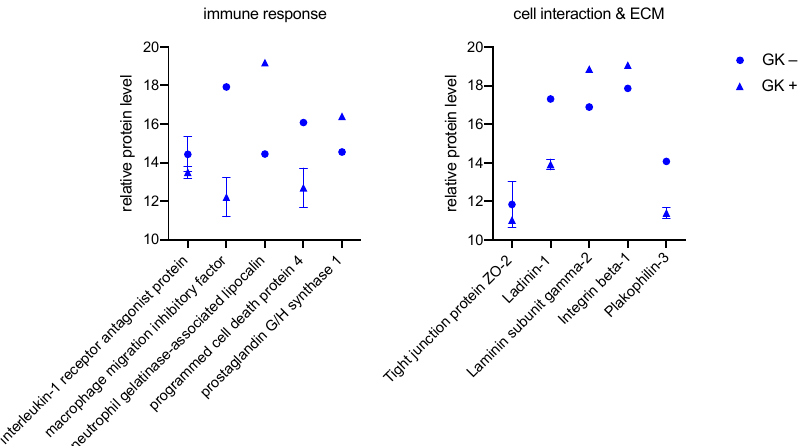
Figure 2. Significant proteins of the immune system ( left ), cell interaction, and ECM ( right ) measured in GK. Protein peak areas were transformed with a log2 scale, and bacterial conditions were compared pairwise with standard conditions using a Student’s t -test ( p < 0.05) and Benjamini-Hochberg correction for multiple tests. “+” indicates culture with bacteria, “–” indicates culture without bacteria.